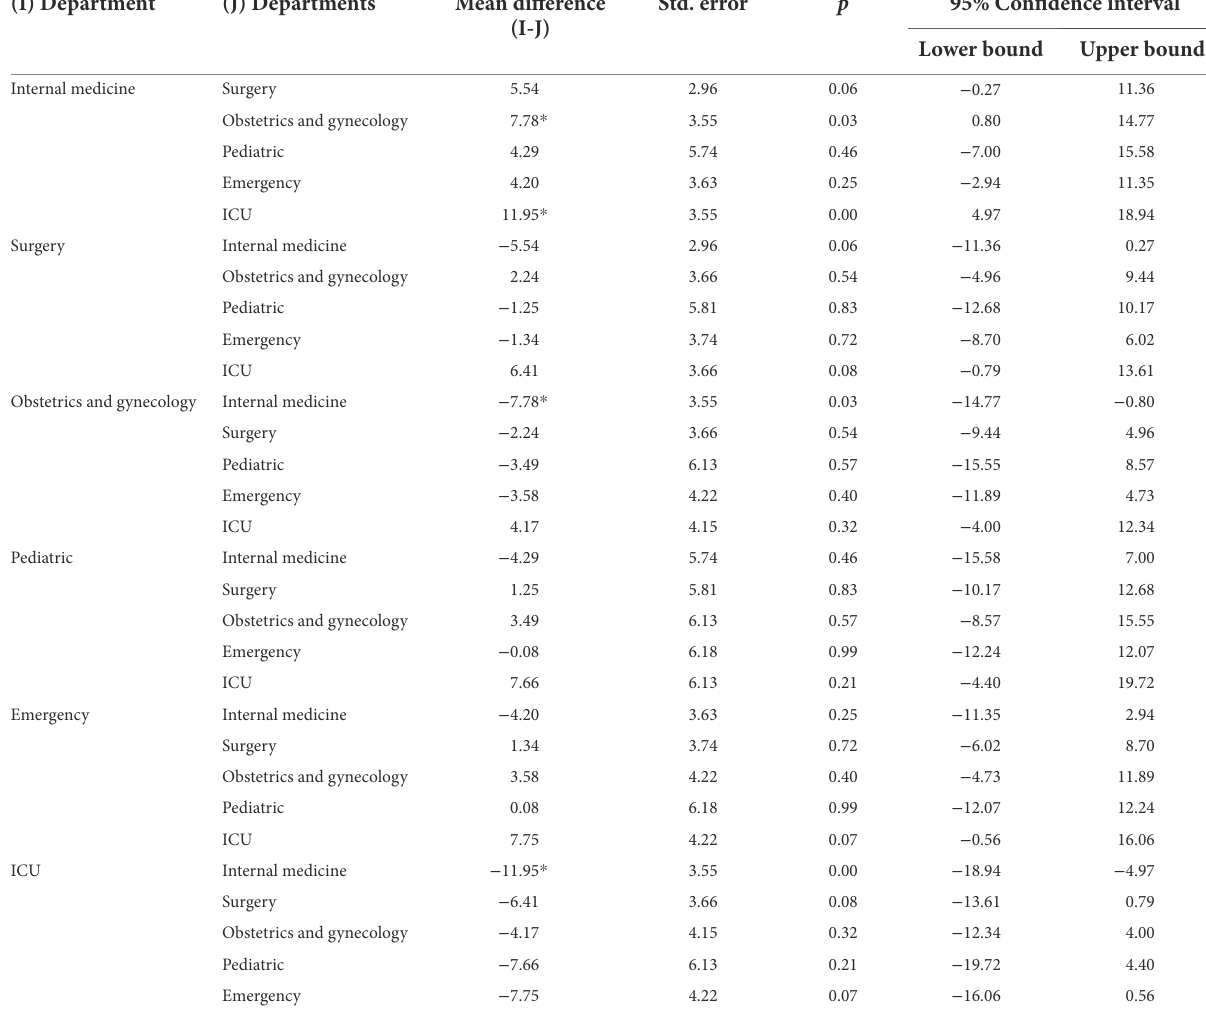
TABLE 6 Multiple comparisons of humanistic care ability scores among nurses from different departments. (I) Department